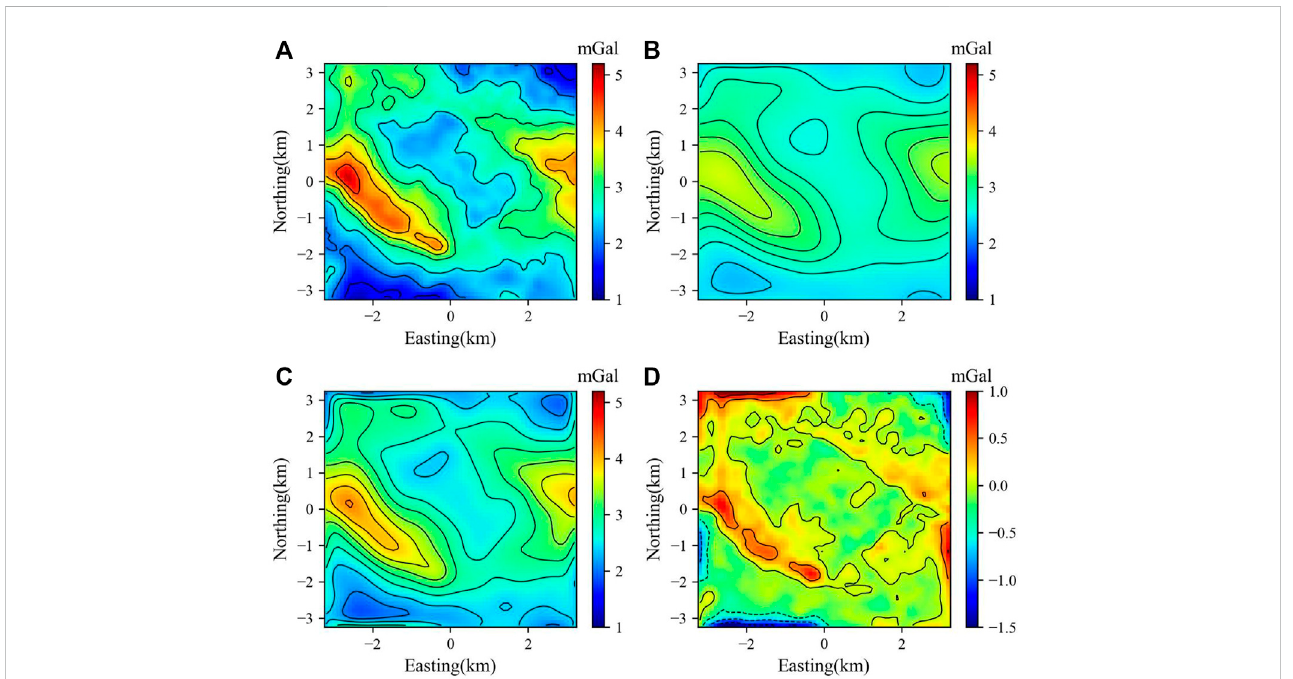
FIGURE 8 (A) ObservedgravityanomalyoftheKauringtestsiteatthegeoid. (B) Calculatedgravityanomalyat500 maltitude(Blakely,1996). (C) DCgravityanomaly